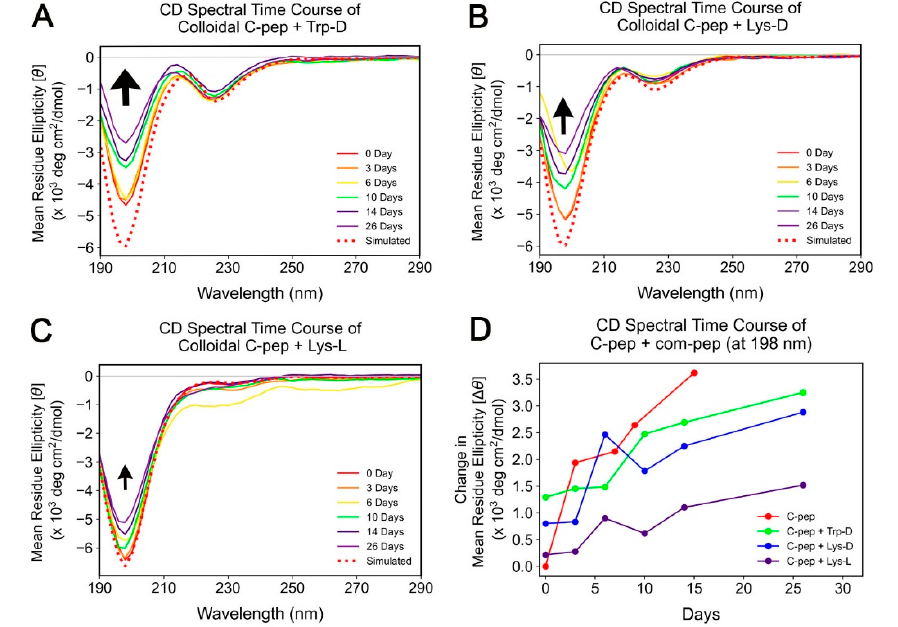
Figure 9. CD spectral time course of colloidal C-peptide co-assembled with ( A ) Trp-D, ( B ) Lys-D, and ( C ) Lys-L respectively. The relative sizes of the vertical arrows denote the relative change in ellipticity at 198 nm. Panel ( D ) illustrates the change in the mean residue ellipticity at 198 nm relative to the simulated spectra of non-interaction between colloidal C-peptide and the 9mer com-peptides; the line due to C-peptide reflects changes relative to 0 day. It shows that Lys-L interacts to the greatest extent with colloidal C-peptide (biggest decrease in rate of increase of [ θ ] 198 relative to that of C-peptide), followed by Lys-D and Trp-D.